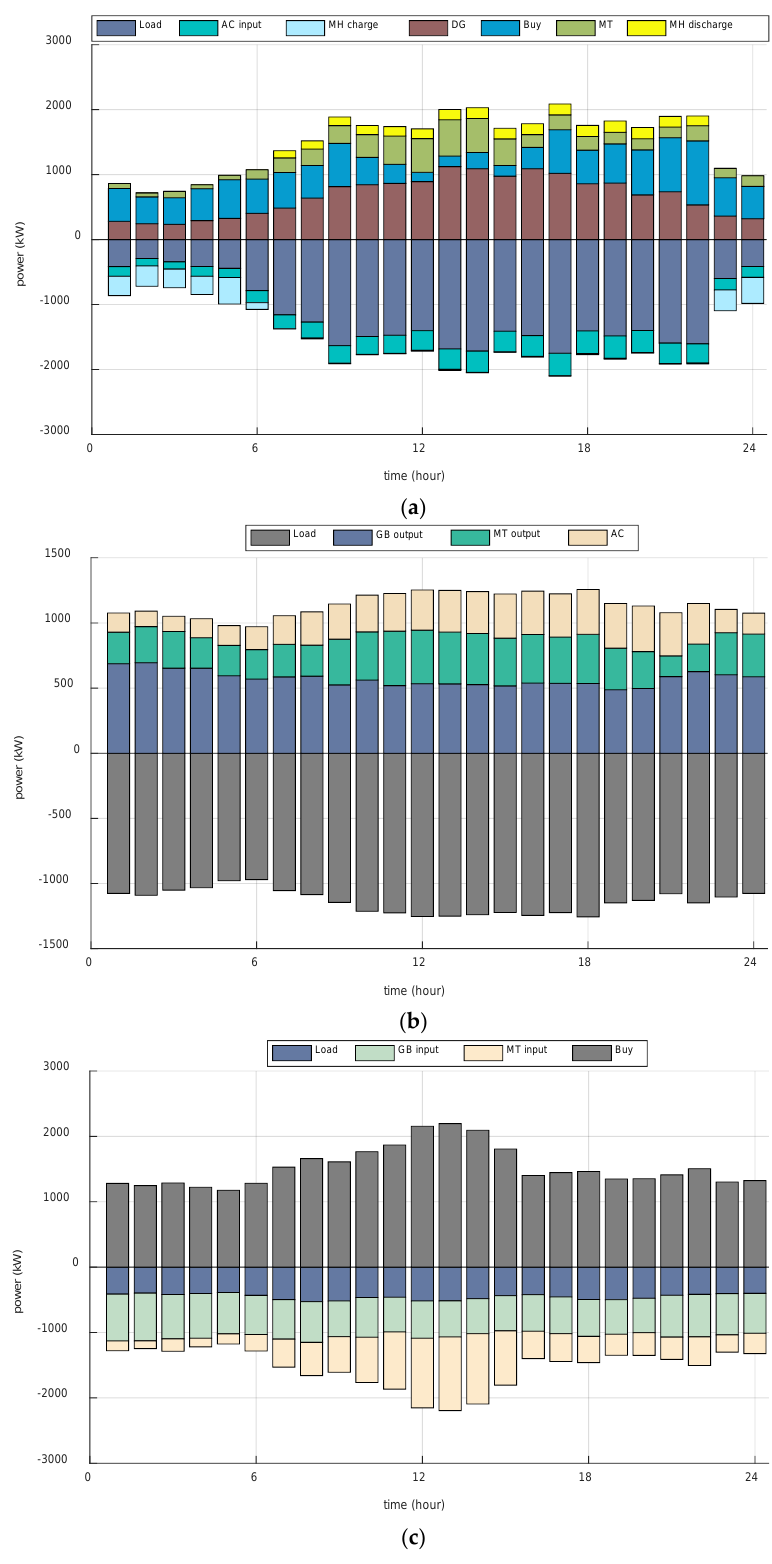
Figure 8. Optimal scheduling results of energy equipment and loads: ( a ) optimal scheduling results in electrical network; ( b ) optimal scheduling results in thermal network; ( c ) optimal scheduling results in gas